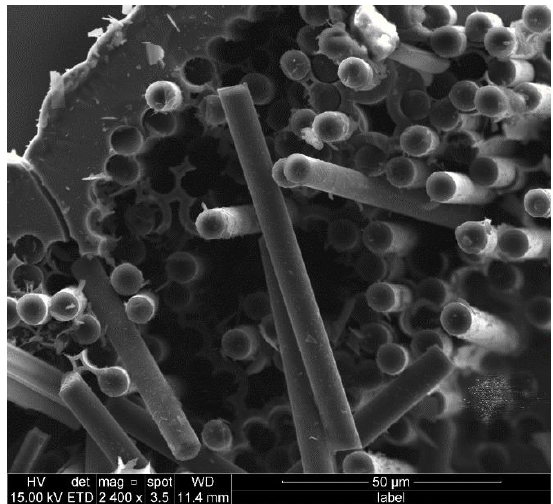
Figure 8. Fiber fracture morphology of sample FF_2.